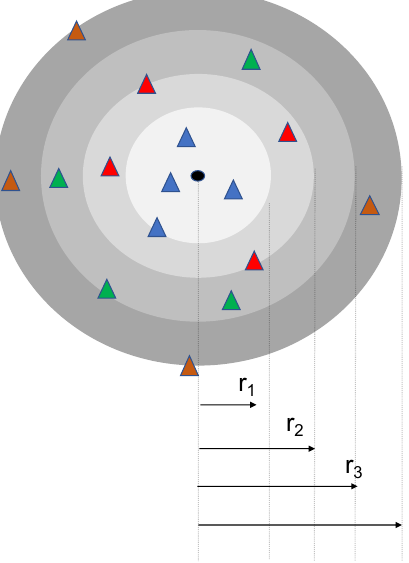
Figure 3. Illustration of the scheduling with n u = 4. The number of RR is adjusted with respect to the furthest node in each group, to say i , situated at distance r i corresponding to the radius of the ball containing in u − 1